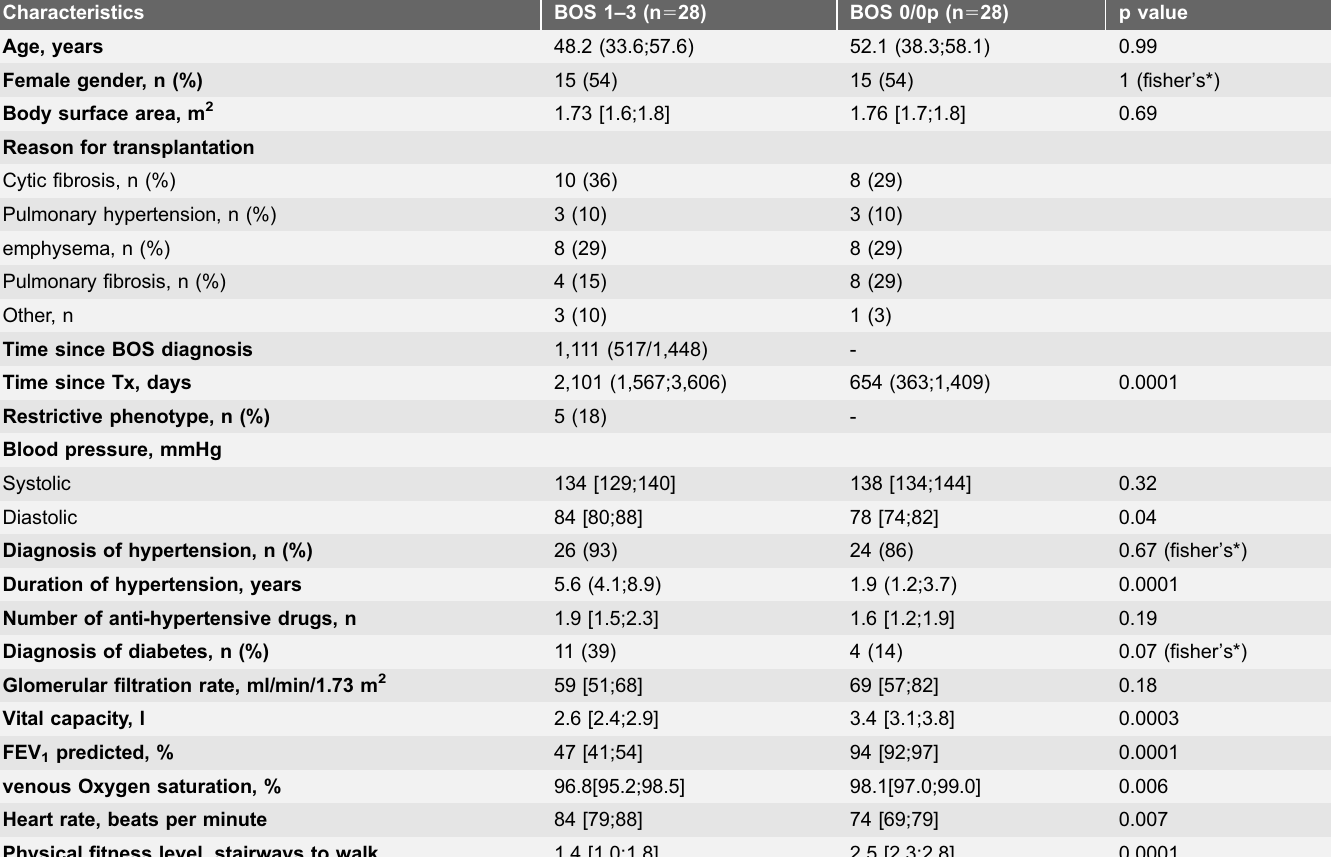
Table 1. Patient